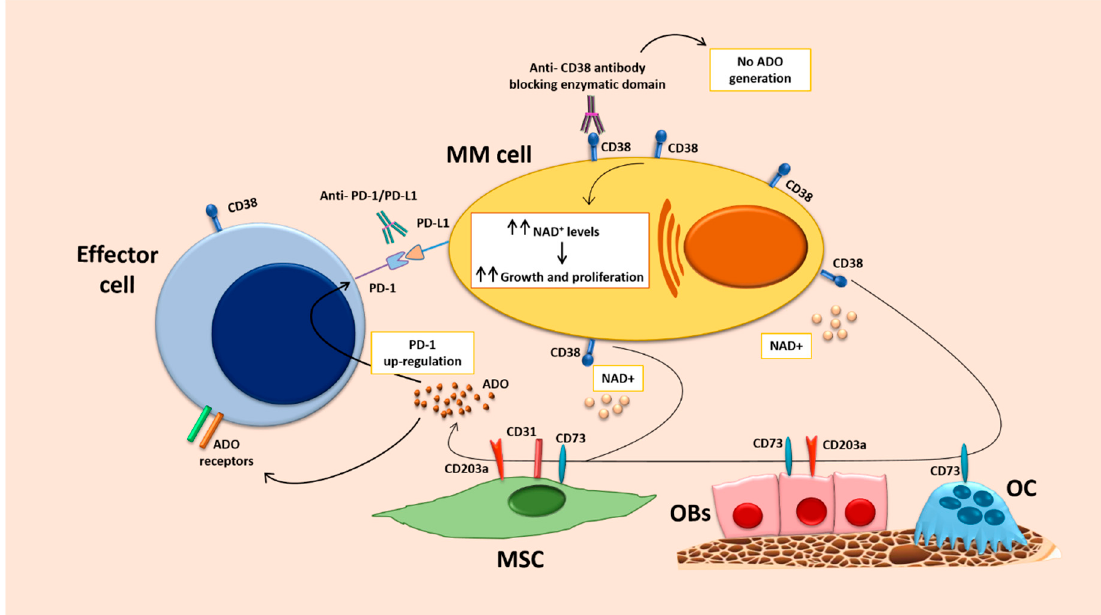
Figure 2. Mechanistic hypothesis behind a synergistic combination between PD-1/PD-L1 blockade and anti-CD38 antibodies inhibiting its enzymatic functions. Abbreviations: ADO, adenosine; MM, multiple myeloma; MSCs, mesenchymal stromal cells; OBs, osteoblasts; OC, osteoclast.